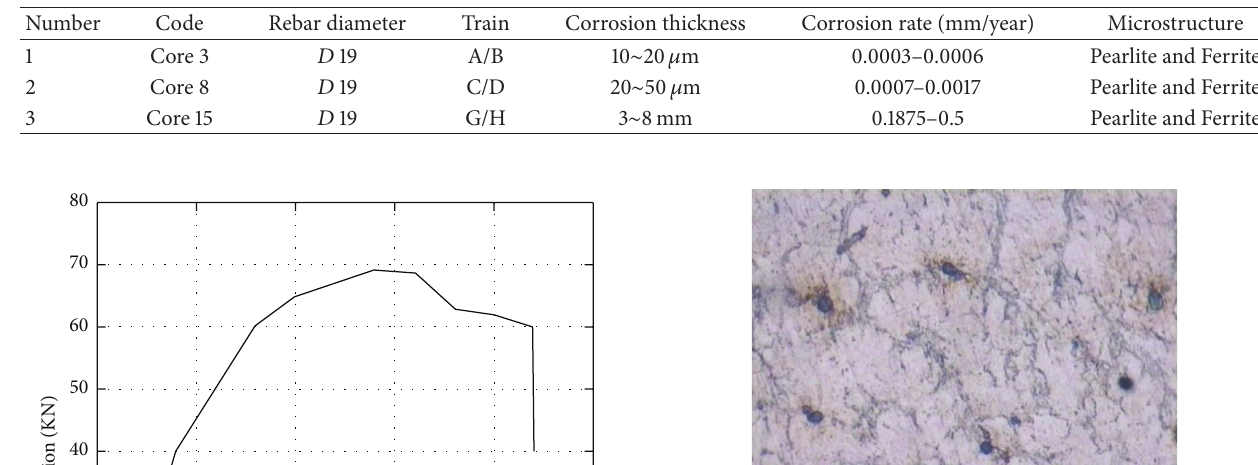
Table 5: Corrosion thickness of rebar.